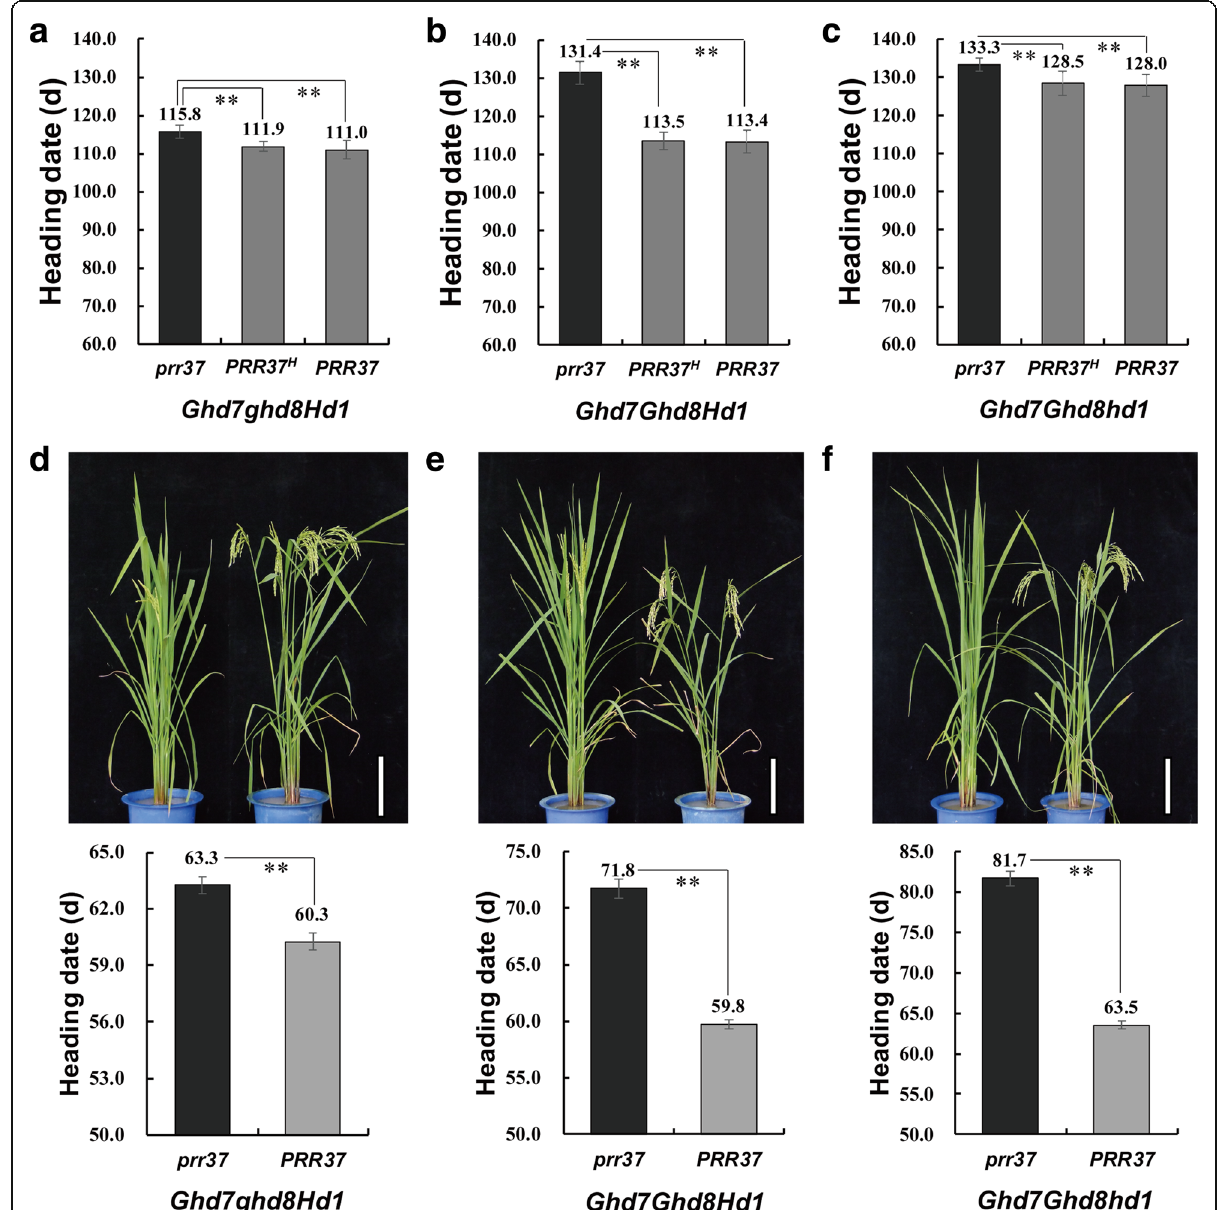
Fig. 3 PRR37 promotes rice heading in the specific backgrounds under NSD and SD conditions. Comparisons of heading date among different alleles of PRR37 in the backgrounds Ghd7ghd8Hd1 a , Ghd7Ghd8Hd1 b and Ghd7Ghd8hd1 c under NSD conditions ( n ≥ 10 for each combination). d - f , Pictures (top) and heading dates (bottom) of prr37 and PRR37 in each corresponding background under SD conditions ( n = 4 for each combination). **, P < 0.01 based on Student ’ s t -test. PRR37 H , the heterozygous allele of PRR37 . Scale bars: 20 cm for d , e and